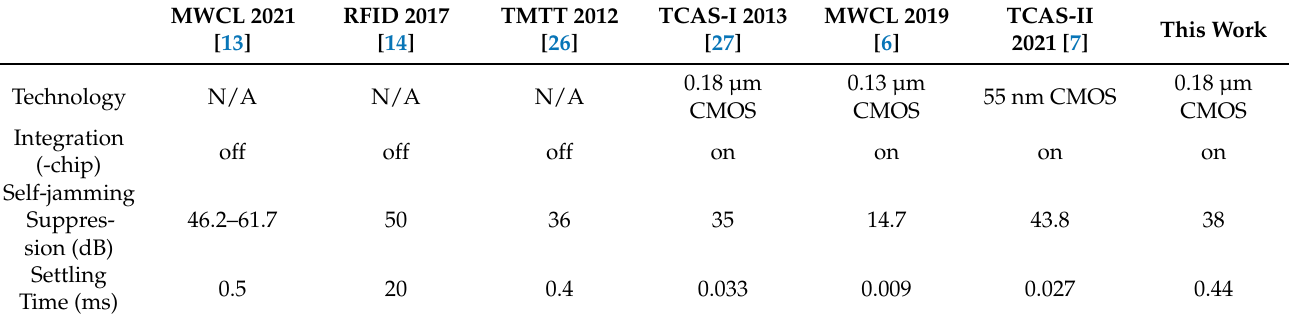
Figure 20. The chip test result of the differential output of the mixer. Table 1. Comparison between this work and state of the